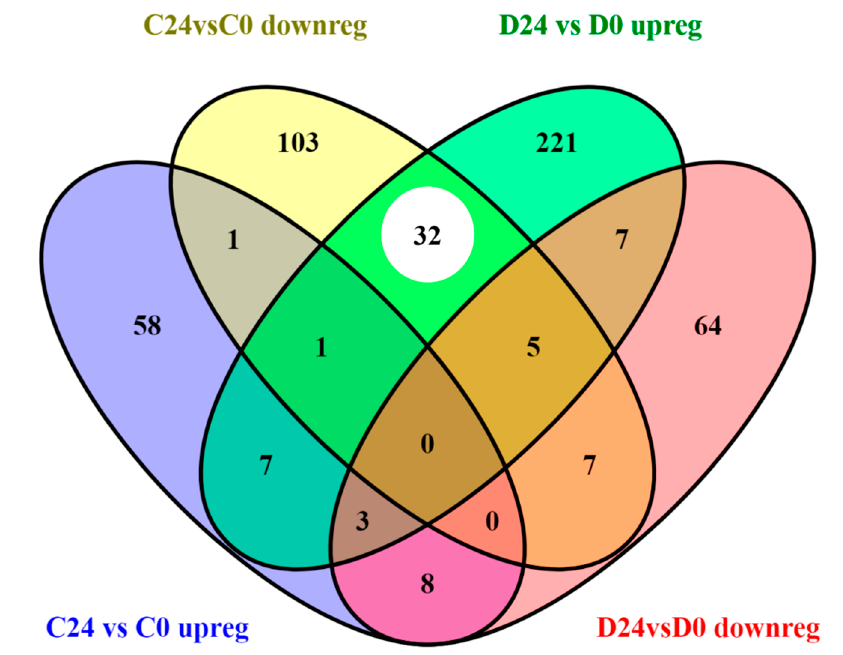
Figure 5. Venn diagram of the number of functions (Gene Ontology biological processes and KEGG pathways) altered in unique probes up and downregulated in C24vsC0 (1668 DE probes) and D24vsD0 (2784 DE probes) groups, respectively. White circle shows coincident functions altered by genes with opposite regulation (upregulated in D24vsD0 and downregulated in C24vsC0).